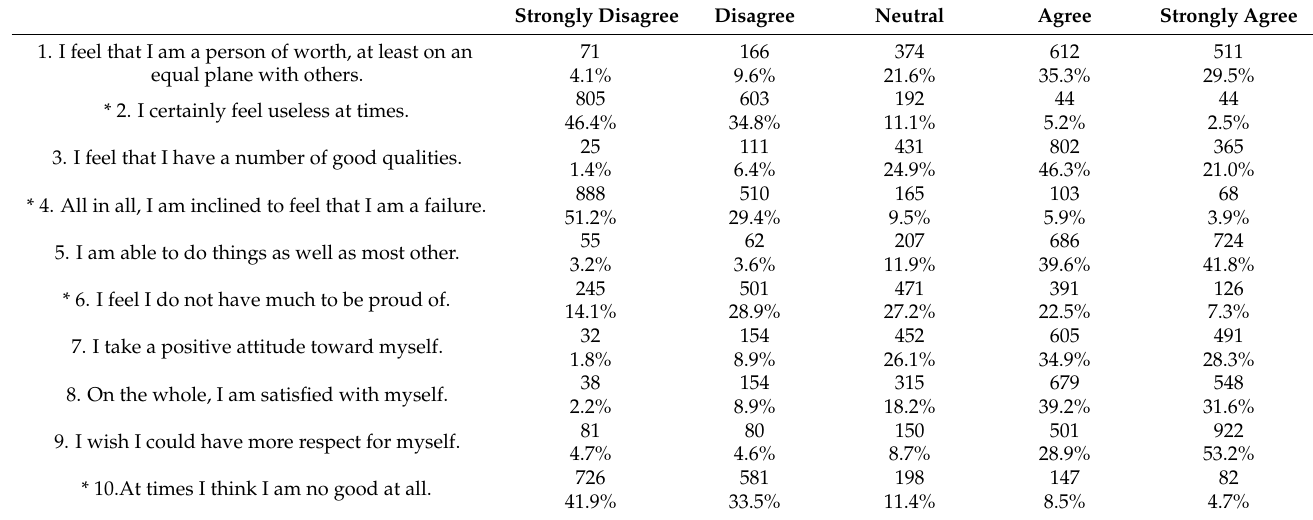
Table A2. Ten-Item Rosenberg Self-Esteem Scale from Nine-City Survey Data.